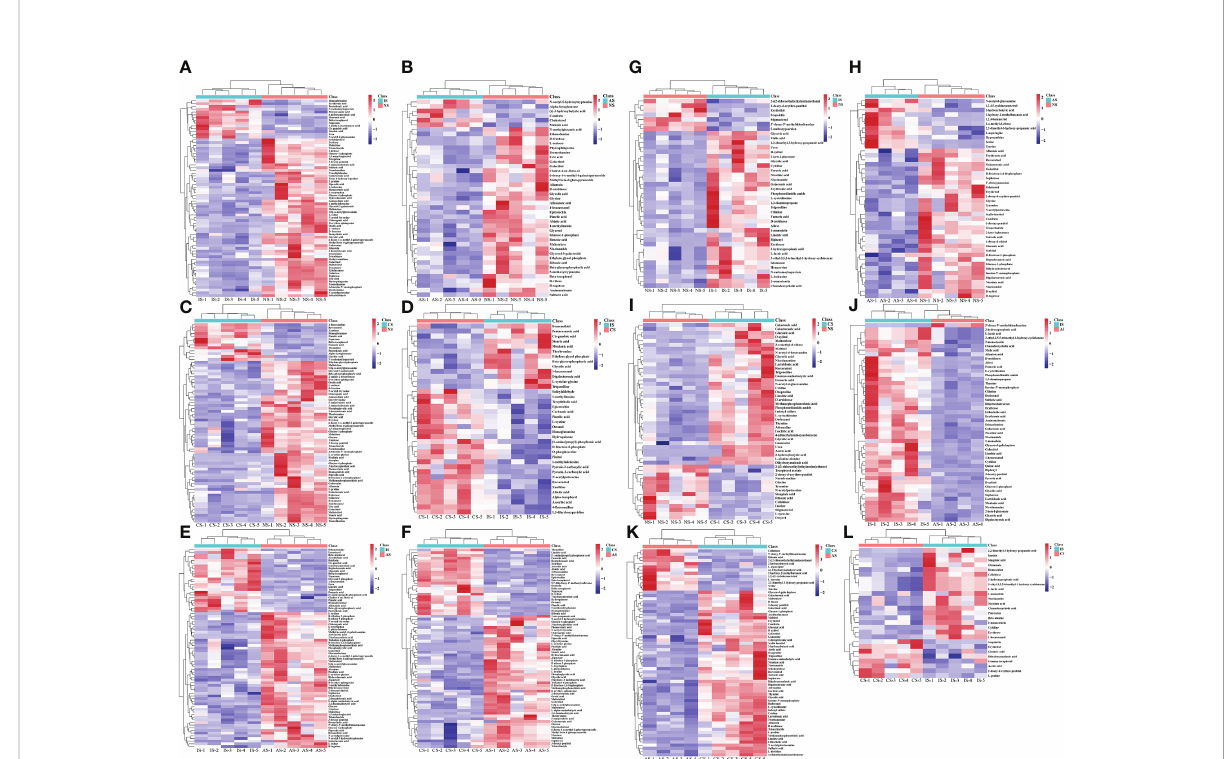
FIGURE 2 Heat maps of differential metabolites in the gill (A – F) and hemolymph (G – L) . (A, G) : IS/NS; (B, H) : AS/NS; (C, I) : CS/NS; (D, L) : IS/CS; (E, J) : IS/ AS; (F, K) : CS/AS. The abscissa and ordinate represent sample names and differential metabolites, respectively. Colors from blue to red indicate low to high expression abundance of